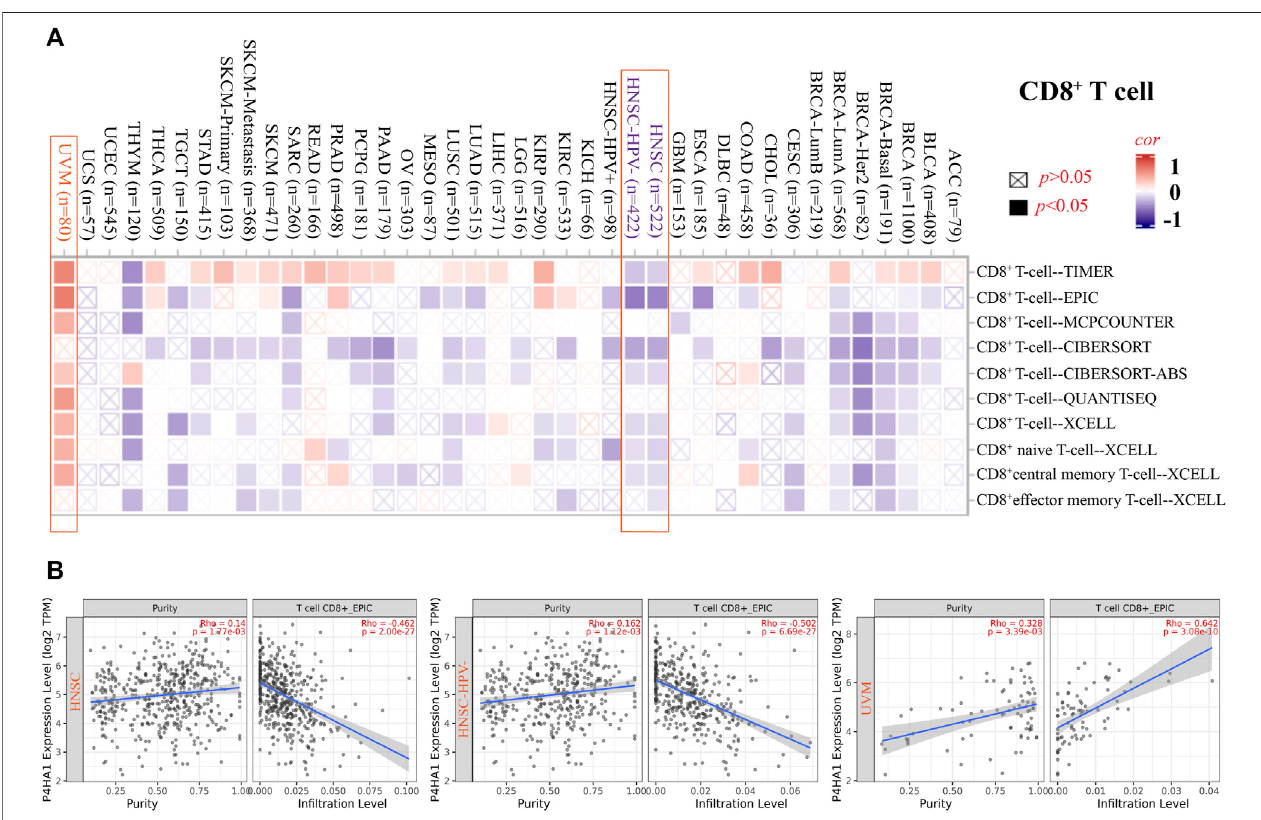
FIGURE 5 | Correlation analysis between SND1 expression and immune in fi ltration of CD8 + T cells. (A,B) Different algorithms (TIMER, EPIC, MCPCOUNTER, CIBERSORT, CIBERSORT-ABS, QUANTISEQ, and XCELL) were applied to con fi rm the potential correlation between the expression level of P4HA1 and the in fi ltration level of CD8 + T cells across different types of tumors in